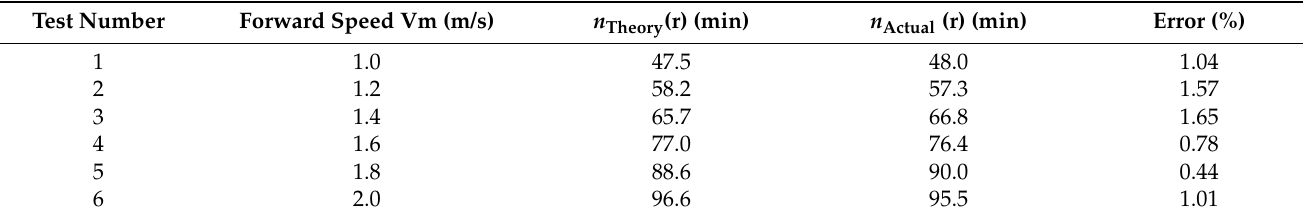
Table 6. Value and error of actual and theoretical speed of rotary